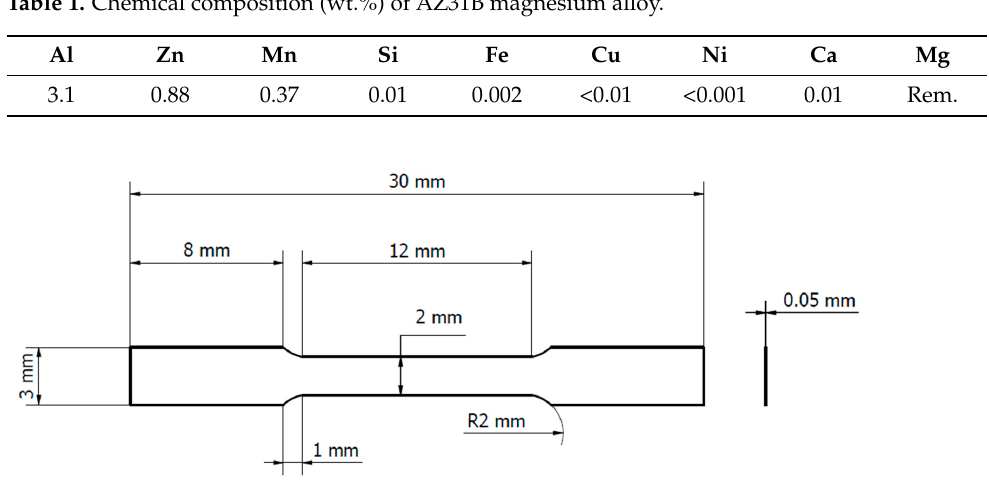
Figure 1. Specimen shape and dimensions.